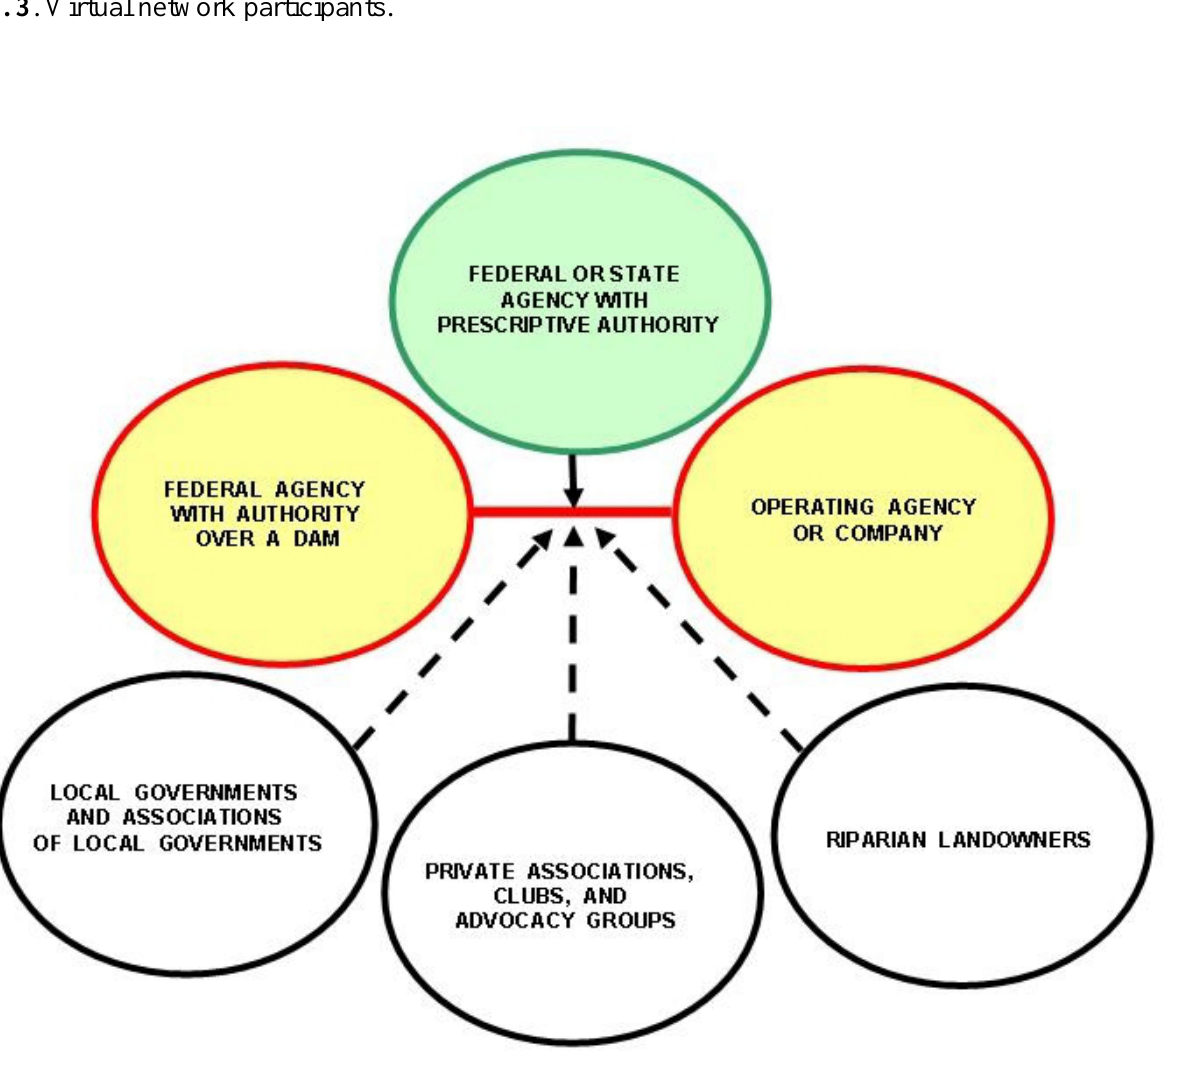
Fig. 3 . Virtual network